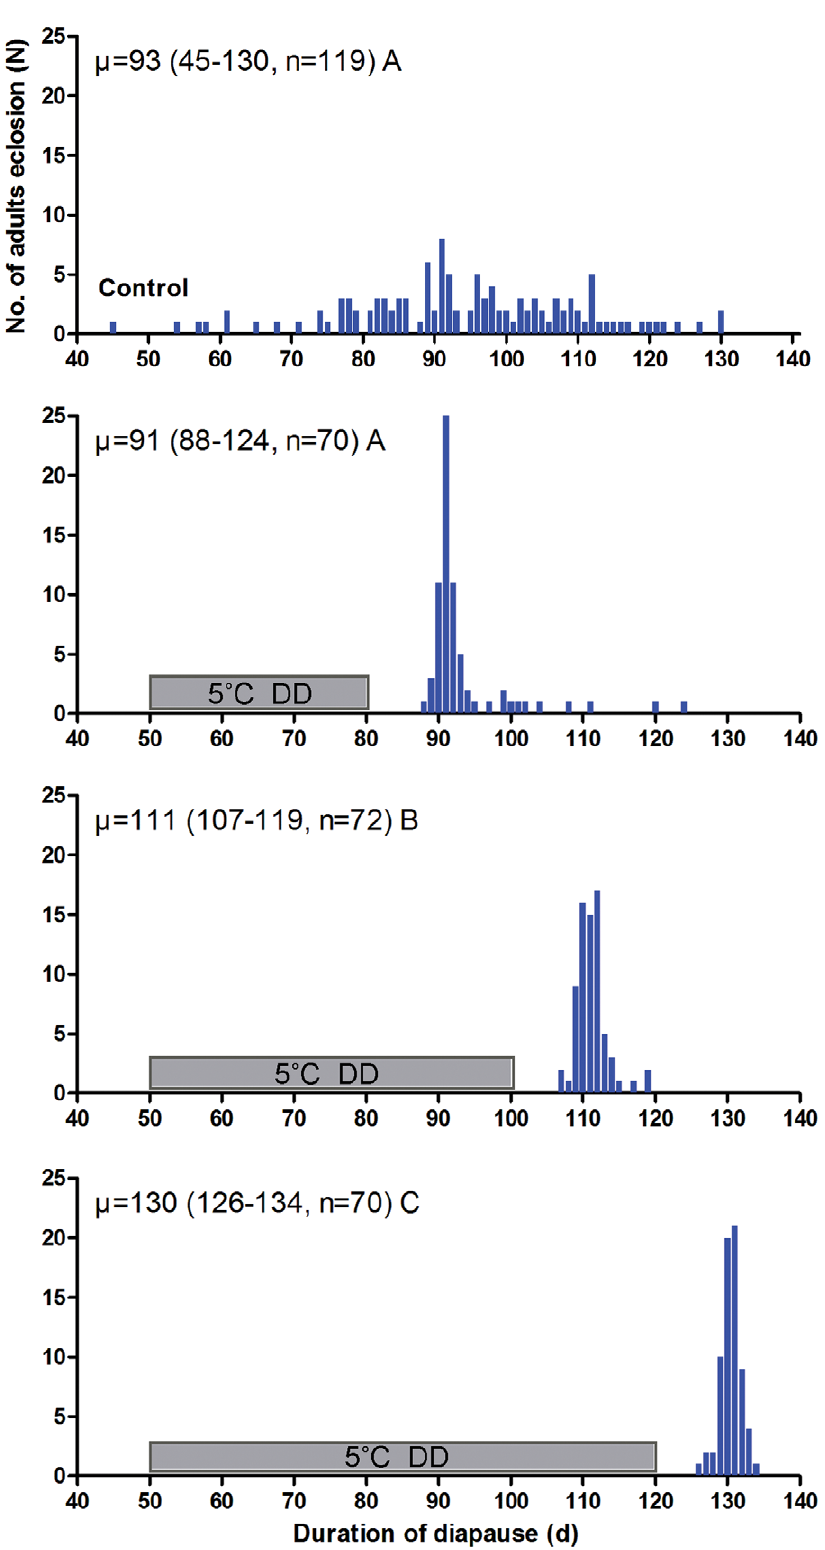
Figure 3. Frequency distribution of adult eclosion in winter diapausing pupae of P.melete. The winter diapausing pupae were transferred to LD12.5:11.5 at 20 u C after exposure to 5 u C and DD for different days. The hatched bar indicates the period of cold exposure. Values followed by different letters are significantly different by Kruskal-Wallis test and Bonferroni multiple comparison ( x 2=212.204,d.f.=3,P=0.0001 , 0.01).